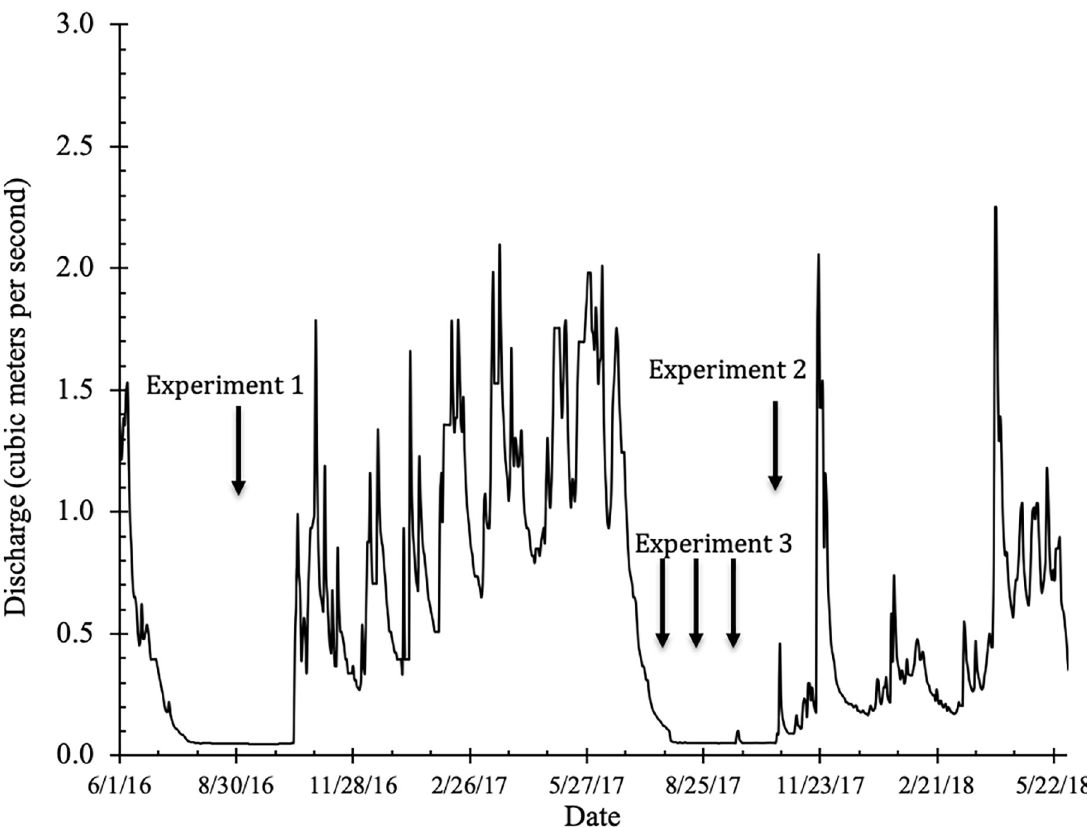
Fig 3. Hydrograph of Sugar Creek during the period of study, showing the low flow conditions during which the studies took place, about 0.03 m 3 /s. For comparison, the mean annual discharge of Sugar Creek is 0.5 m 3 /s.